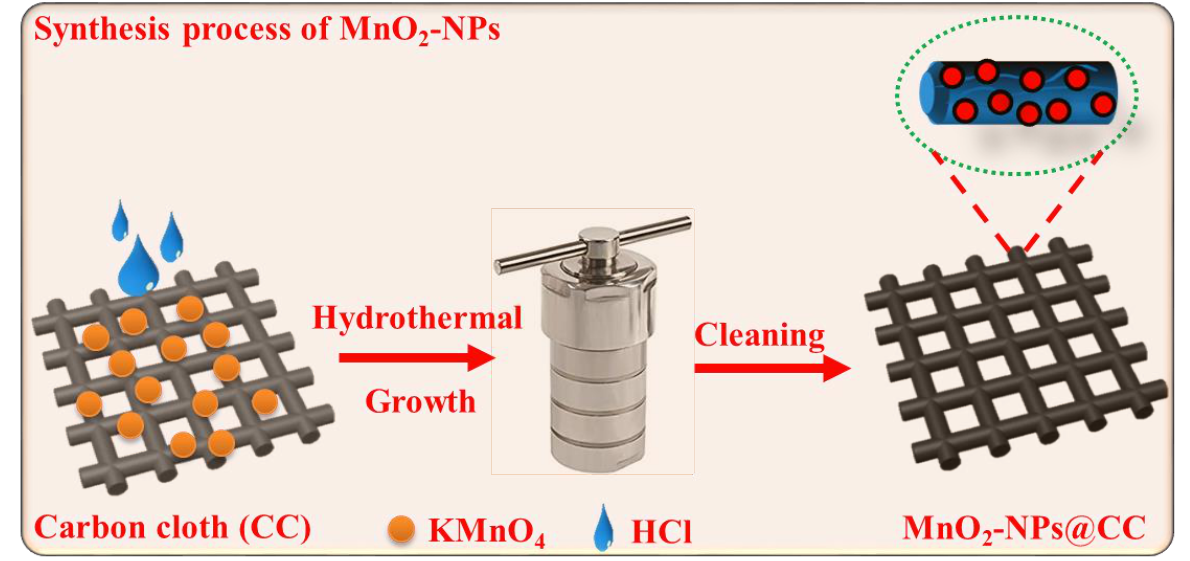
Figure 1. Schematic representation of a typical synthesis procedure of MnO 2 -NPs@CC.